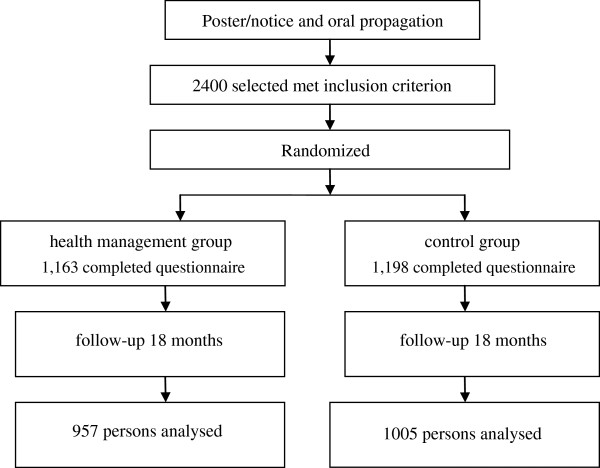
Flow diagram of participants’ progress in the randomized trial.